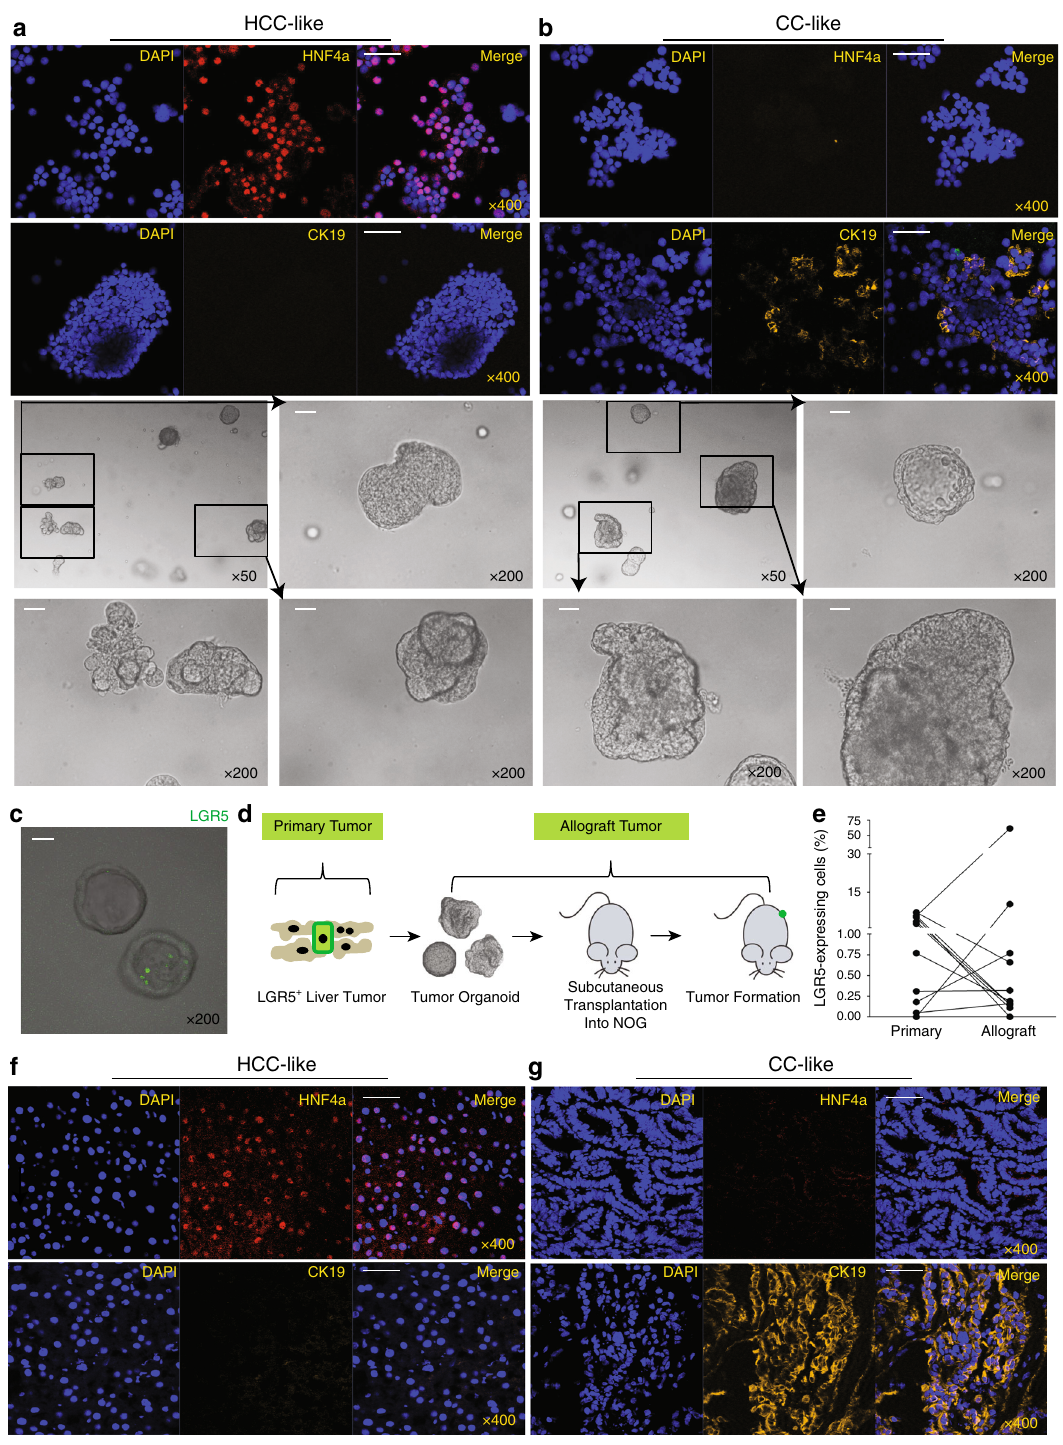
Fig. 3 Maintenance of LGR5-expressing cells in liver tumor organoids and allograft tumors. a , b Representative pictures showing organoid lines that predominately express the hepatocyte marker HNF4 ɑ ( a ) or the cholangiocyte marker CK19 ( b ) (upper panels: IF staining; lower panels: bright- fi eld microscopic pictures, scale bar = 50 µ m). c Representative pictures showing the presence of LGR5- expressing cells in organoids. LGR5-driven GFP: green. Scale bar = 50 µ m. d An outline of the experimental strategy used to transplant tumor organoid lines into immunode fi cient mice. e The percentages of LGR5-expressing cells in allograft tumors and the corresponding primary tumors (primary vs. allograft: 2.8 ± 0.8% vs. 6.8 ± 5.6%, n = 11, P = 0.3577). f , g Representative pictures of allograft tumors that mainly express either the hepatocyte marker HNF4 ɑ ( f ) or the cholangiocyte marker CK19 ( g ). Scale bar = 50 µ m. Mean± SEM. Source data are provided as a Source Data fi